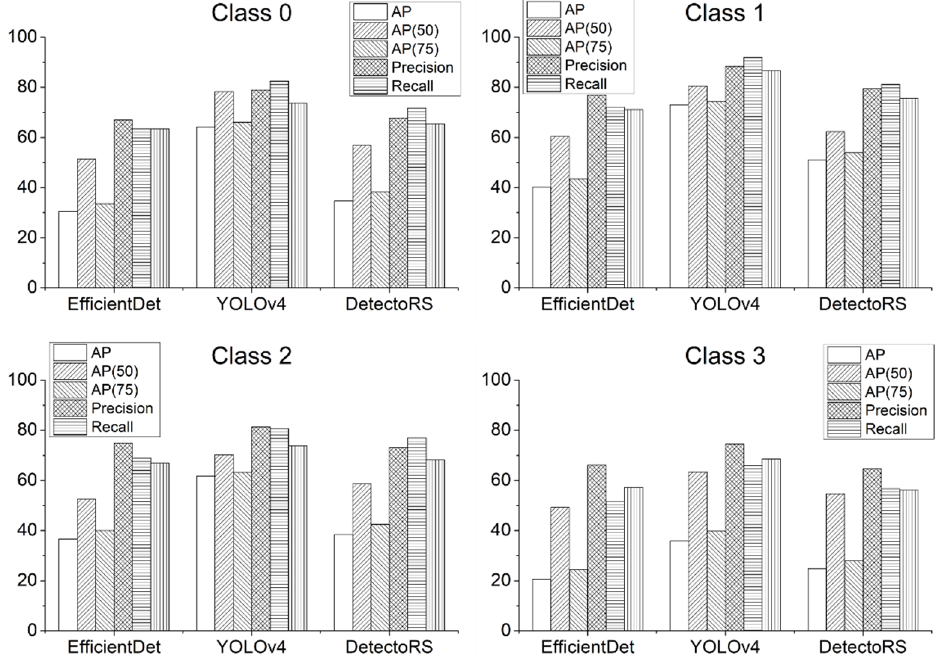
Figure 3. Performance comparison by class.